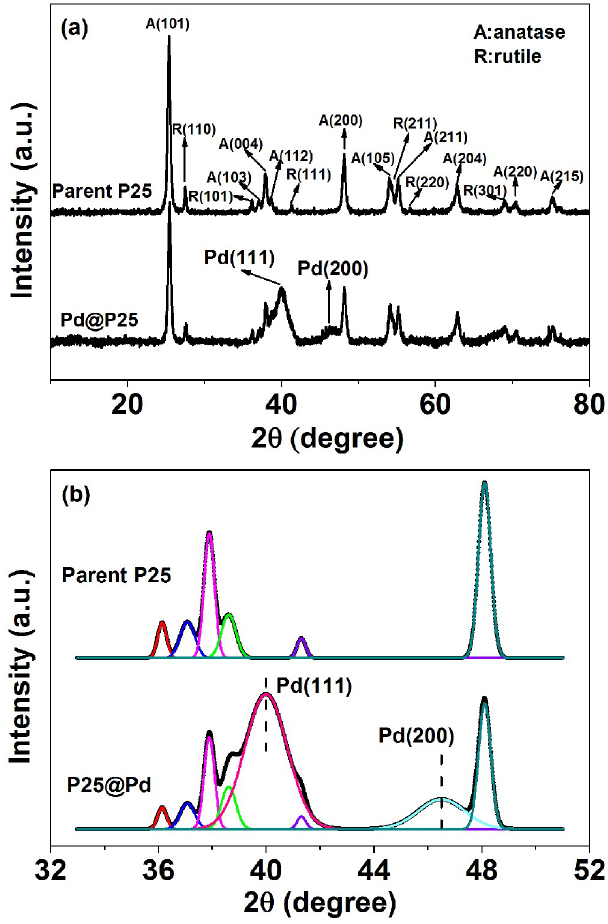
Figure 2. X-ray di ff raction (XRD) patterns of parent P25 support and P25@Pd core-shell catalyst: Figure 2. X-ray diffraction (XRD) patterns of parent P25 support and P25@Pd core-shell catalyst: ( a ) ( a ) Experimental data, ( b ) peak fitting Experimental data, ( b ) peak fitting results.